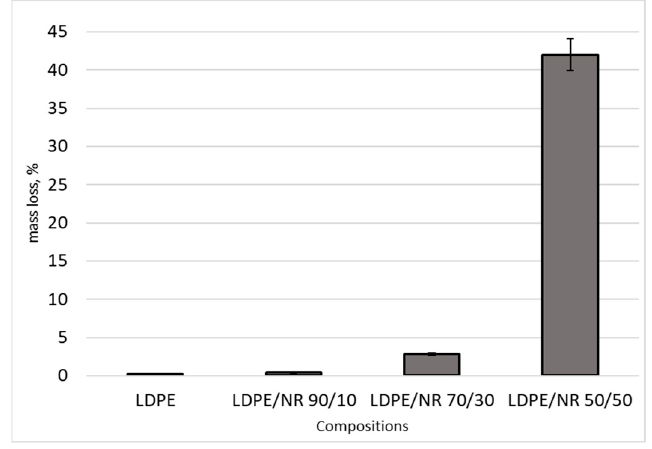
Figure 7. Sample weight loss over 24 months: LDPE 100 and LDPE/NR composites with NR content of 10, 30, 50 wt%.